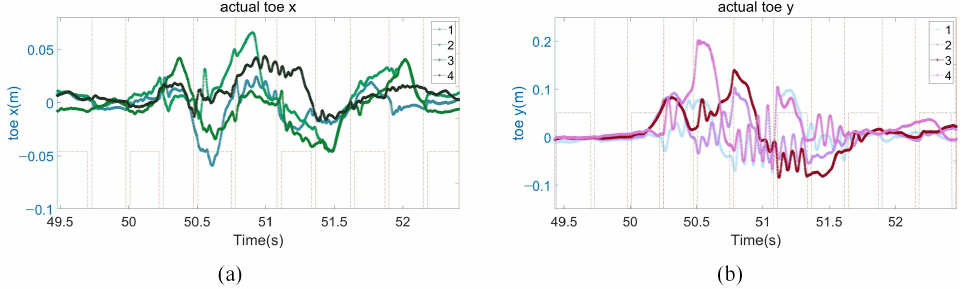
Figure 7. Disturbance recovery experiment data. ( a ) The x-direction position of the foot end of the four legs; ( b ) the y-direction position of the foot end of the four legs.